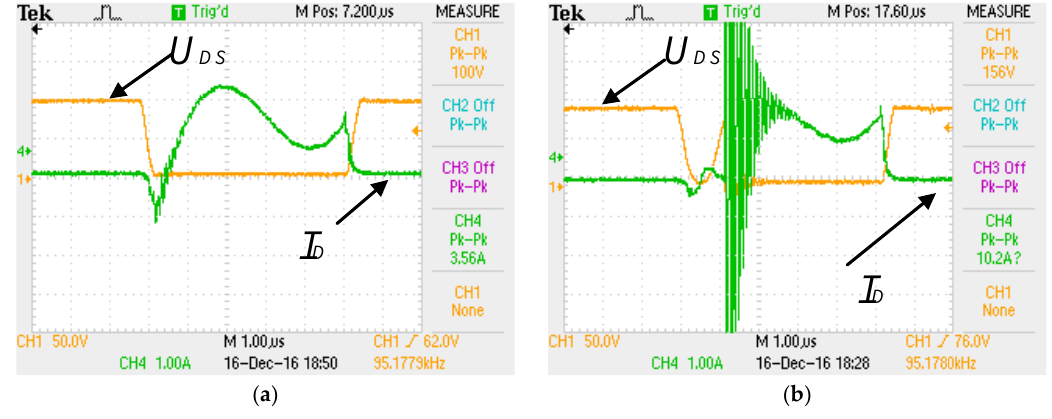
Figure 6. Voltage and current of MOSFET ( a ) t DT = 500 ns; ( b ) t DT = 1.2 us.